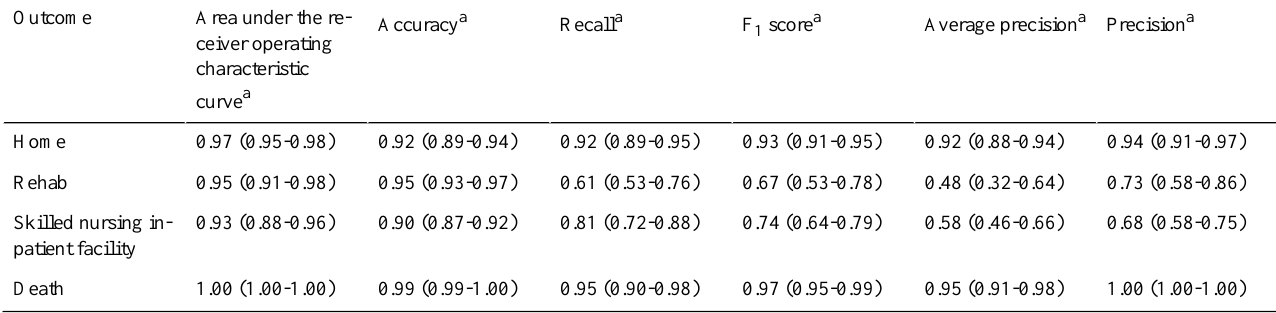
Table 4. Model performance in the hold-out test set by discharge